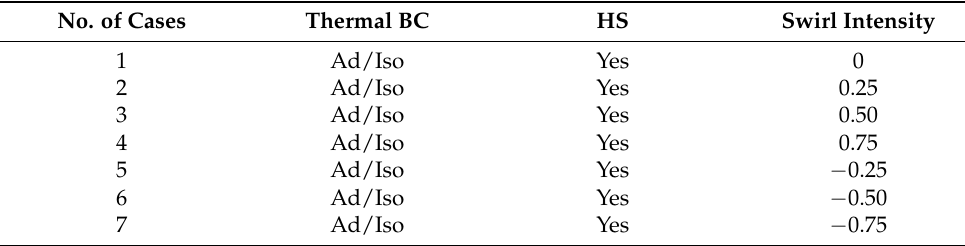
Figure 10. Total temperature profiles and swirl at inlet of guide vanes. Table 1. Simulation